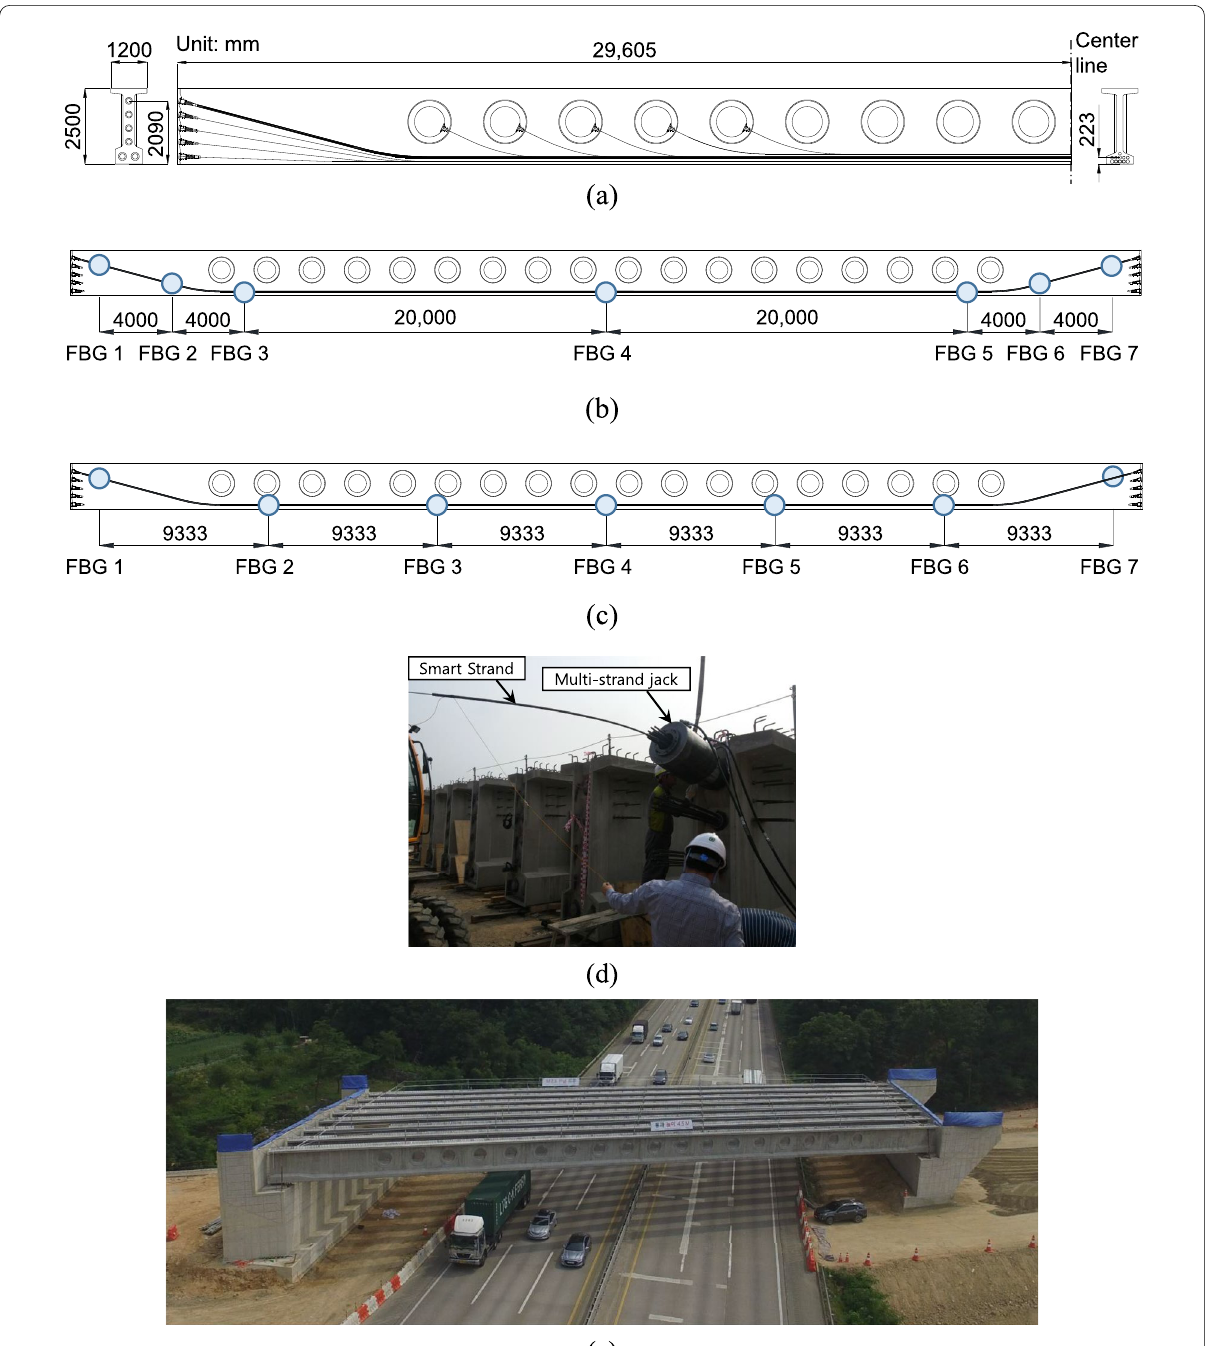
The PF of a strand can vary slightly from strand-to-strand even in a duct due to the different degree of interlocking and slip at a hole of the anchor head. This aspect was ana- lyzed by Cho et al. (2015) using elasto-magnetic sensors.